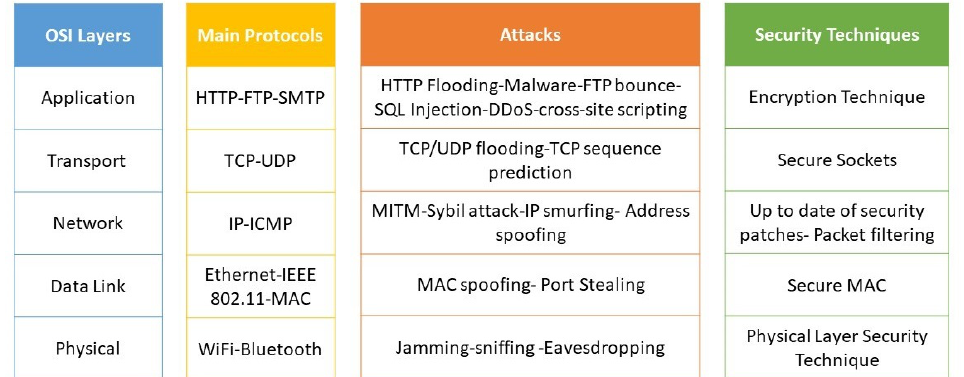
Figure 1. A generic wireless OSI Model information consisting of the layers, main protocols, main attacks, security